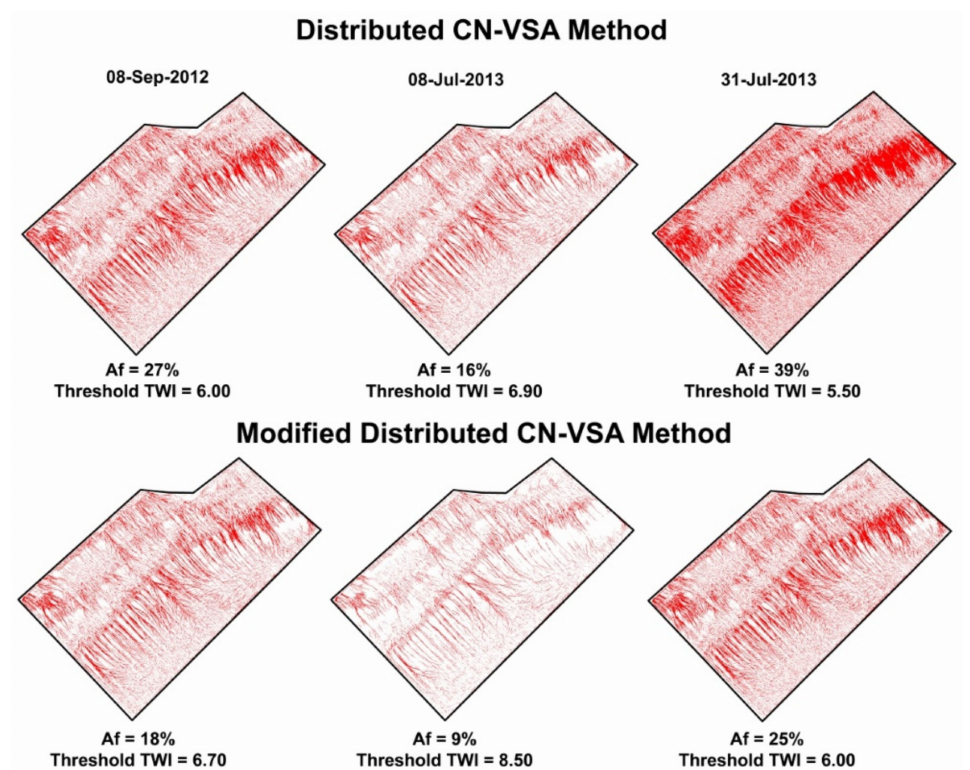
Figure 12. Comparison of spatial distribution of runoff estimated by distributed CN–VSA method and modified distributed CN–VSA method of summer rainfall